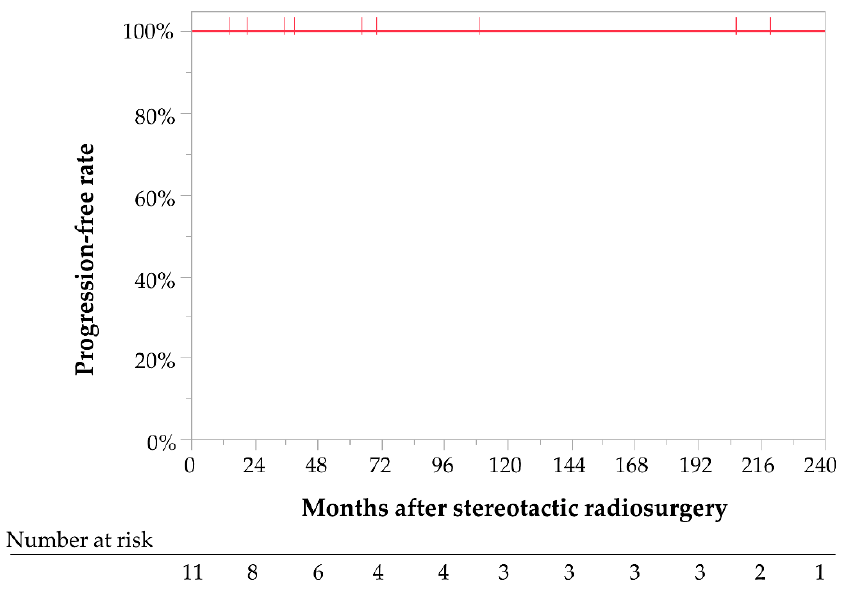
Figure 2. Kaplan–Meier curve for progression-free rates for all patients with intraventricular menin- giomas treated with stereotactic radiosurgery.